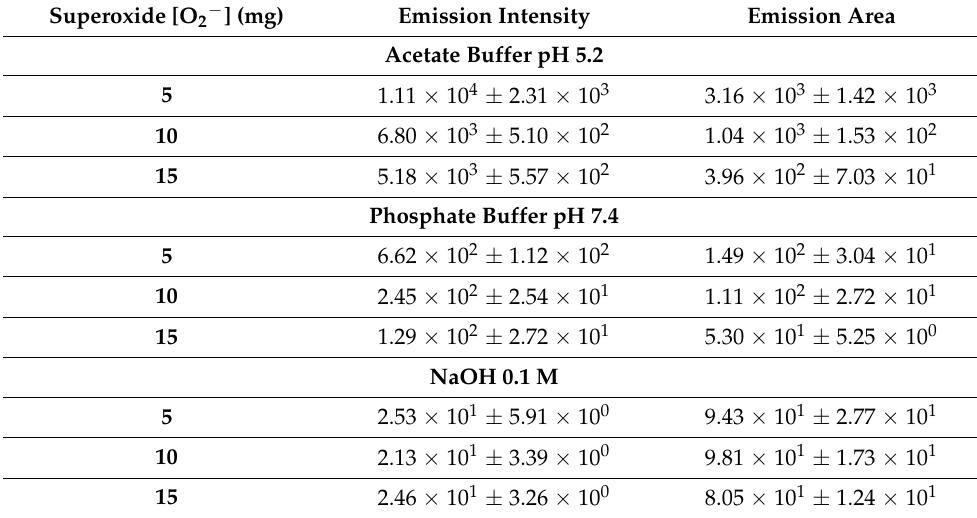
Table 2. Measured ratios between the obtained light-emission maxima and calculated area of the CL reactions of MeOBr-Cla and Clz ( MeOBr − Cla ). Measurements were performed in aqueous solutions Clz with the addition of either sodium acetate buffer pH 5.2 (1%), phosphate buffer pH 7.4 (75 mM), or NaOH (0.1 M). Measurements were performed with different amounts of potassium superoxide (5–15 mg), as a superoxide anion source. Assays were performed for a final volume of 500 µ L and a concentration of 5 µ M for both Clz and